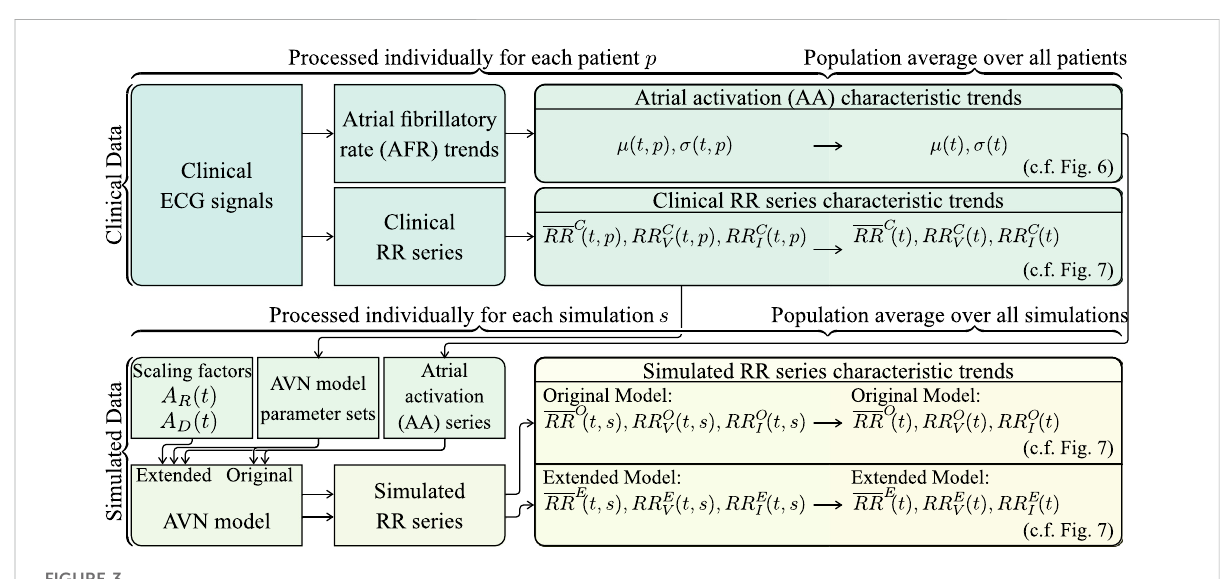
series parameters have an in fl uence on the RR series characteristics. Based on this, the AV node model described in Section 2.3 is extended to account for ANS-induced changes in the AA series by allowing μ ( t ) and σ ( t ) of the Pearson Type IV distribution to vary over time. Moreover, the AV node model was extended by two scaling factors A R and A D , accounting for the effect of changes in autonomic tone on refractory period ( A R ) and on conduction delay ( A D ).